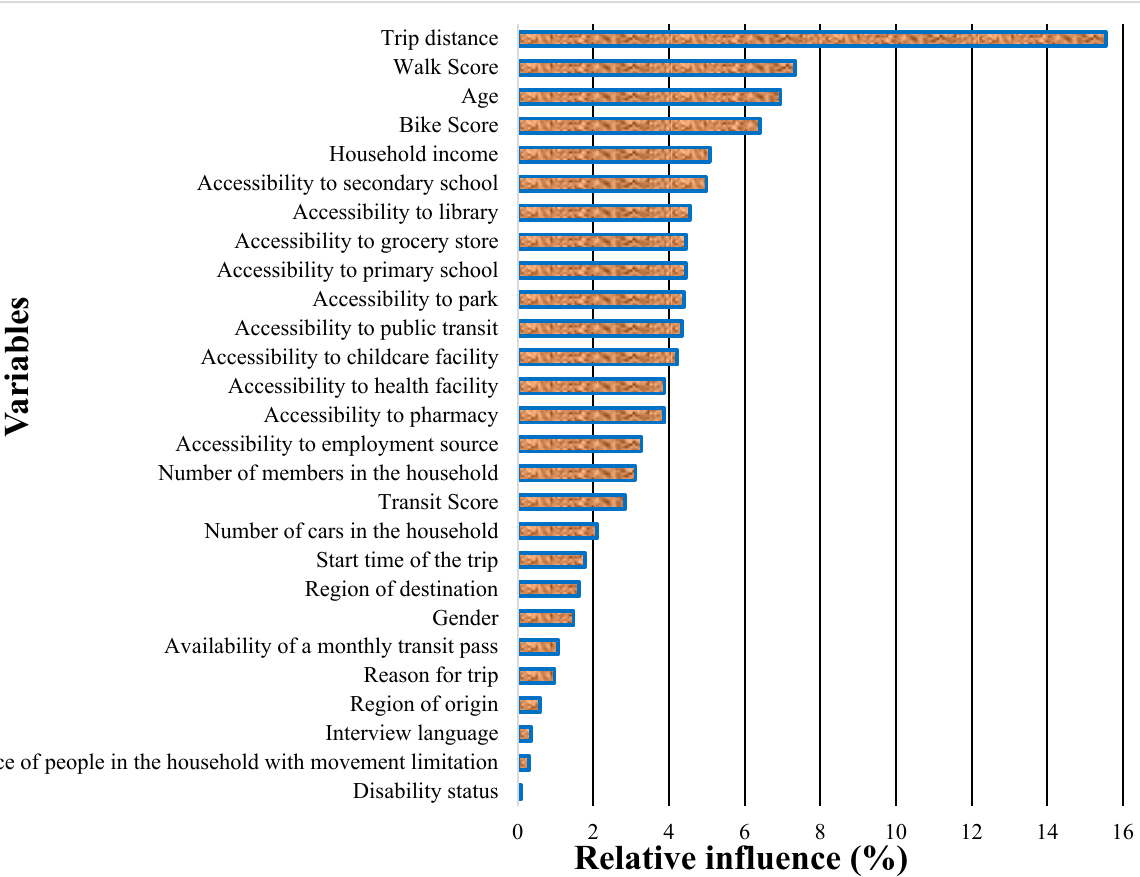
Figure 7. The relative influence of variables on children’s TMC.